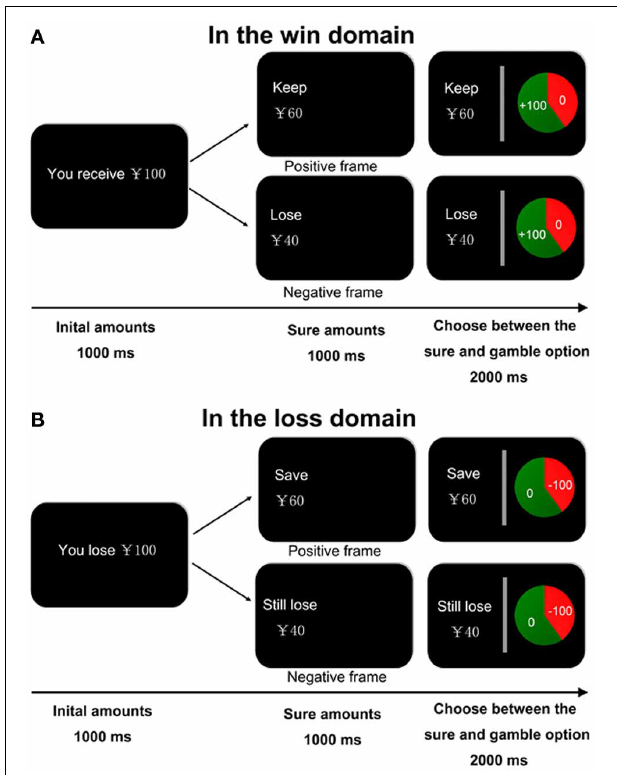
FIGURE 1 | Experimental task design. At the beginning of each trial, a message indicating the starting amount of money was presented for 1000ms. The amount is a win in the win domain (A) and a loss in the loss domain (B) . The participants were informed that they may or may not receive this initial amount of money, depending on their subsequent choices. Then a sure option was showed in the left of the screen for 1000ms. The sure option was framed either positive or negative in both domains. After that, a gamble option, that is, a pie chart depicting the probability of winning (i.e., keep all initial reward in the win domain or lose nothing in the loss domain) or losing (i.e., receive nothing in the win domain or lose the initial amount in the loss domain) was showed in the right of the screen for 2000ms. Participants are required to make a decision within the